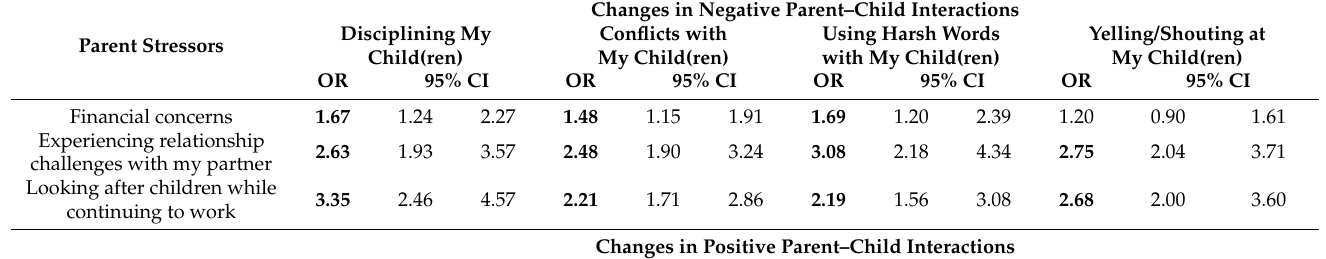
Table 4. Changes in parent–child interactions associated with parent stressors due to the COVID-19 pandemic. Changes in Negative Parent–Child Interactions Parent